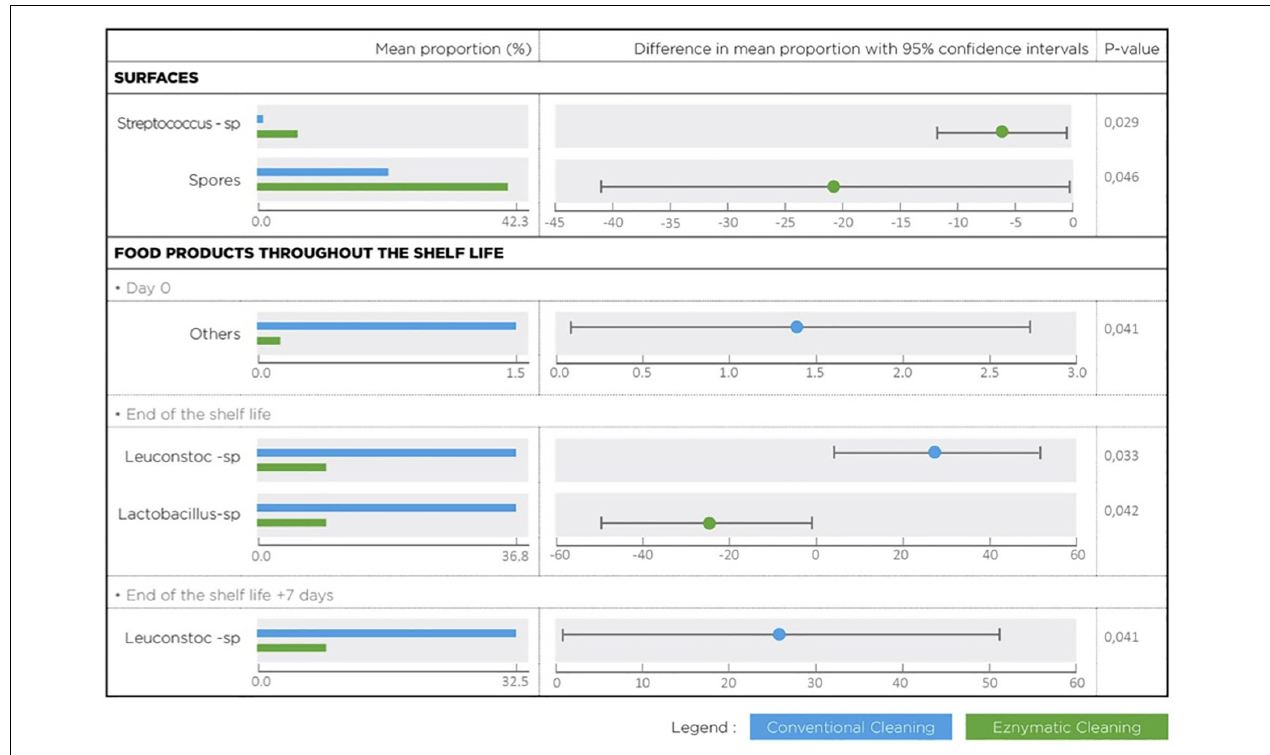
FIGURE 6 | Bacterial species with a statistical difference between conventional and enzymatic cleanings of processing surfaces and in the lasagne throughout its shelf